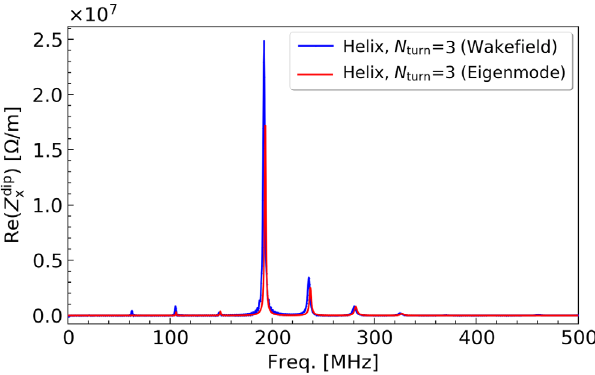
FIG. 11. Real part of the horizontal dipolar transverse impedance of a helix with 3 turns, a symmetric vacuum gap ¼ 44 mm. and L overlap